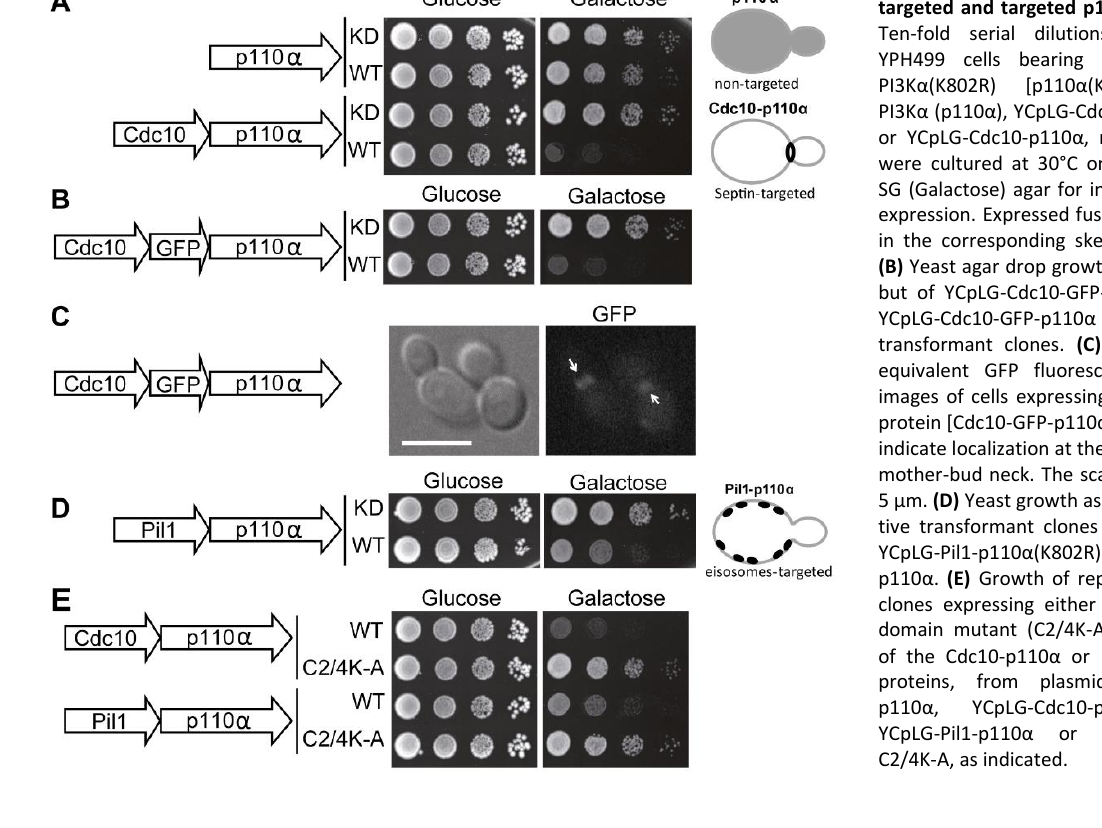
FIGURE 1: Effects on yeast growth of non- targeted and targeted p110α versions. (A) Ten-fold serial dilutions of wild type YPH499 cells bearing plasmids YCpLG- PI3Kα(K802R) [p110α(K802R)], YCpLG- PI3Kα (p110α), YCpLG-Cdc10-p110α(K802R) or YCpLG-Cdc10-p110α, respectively. Cells were cultured at 30°C on SD (Glucose) or SG (Galactose) agar for induction of p110α expression. Expressed fusions are indicated in the corresponding sketches at the left. (B) Yeast agar drop growth assays as in (A) , YCpLG-Cdc10-GFP-p110α representative transformant clones. (C) Bright field and equivalent GFP fluorescence microscopy